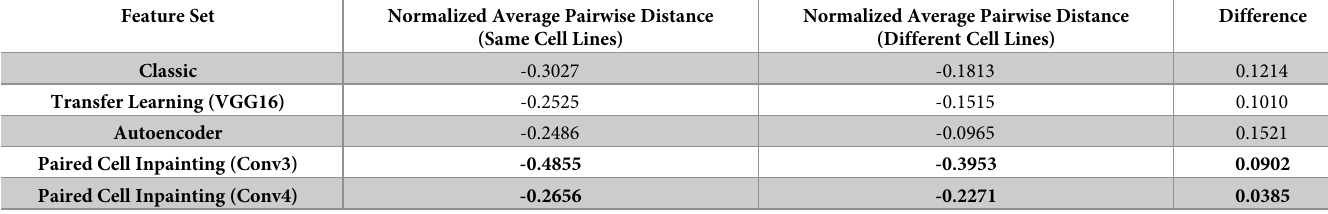
Paired Cell Inpainting (Conv4) 0.0385 Normalized average pairwise distance scores between cells in image pairs with the same GO localization term, with the additional constraint of both images between from either the same cell line, or from different cell lines. We also report the difference between the two sets of scores; a smaller difference means that the model’s performance drops less when cell lines are